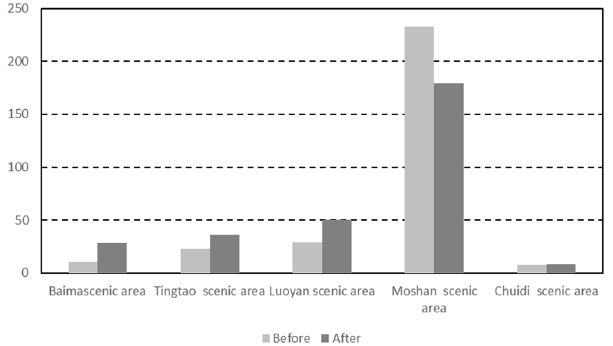
Figure 4. Comparison of urban park use areas before and after the pandemic.